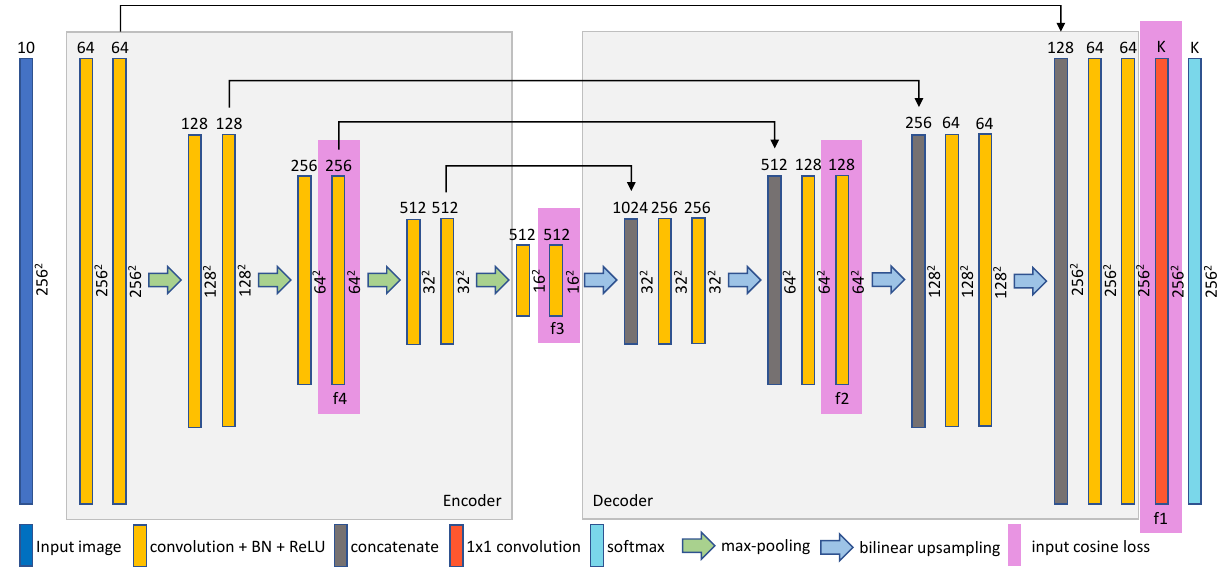
Figure 1. The network architecture. f1 - f4 identify layers that are used as input to the cosine similarity loss in some experiments. Squared numbers indicate the size of the feature maps in pixel, numbers on top of the layers indicate the number of filters. (Fletcher, 2012). We use the four spectral bands with a ground noise to be expected in the remaining data. Figure 3 shows one sampling distance (GSD) of 10 m (red, green, blue, near in- of the two images and the reference for that dataset.